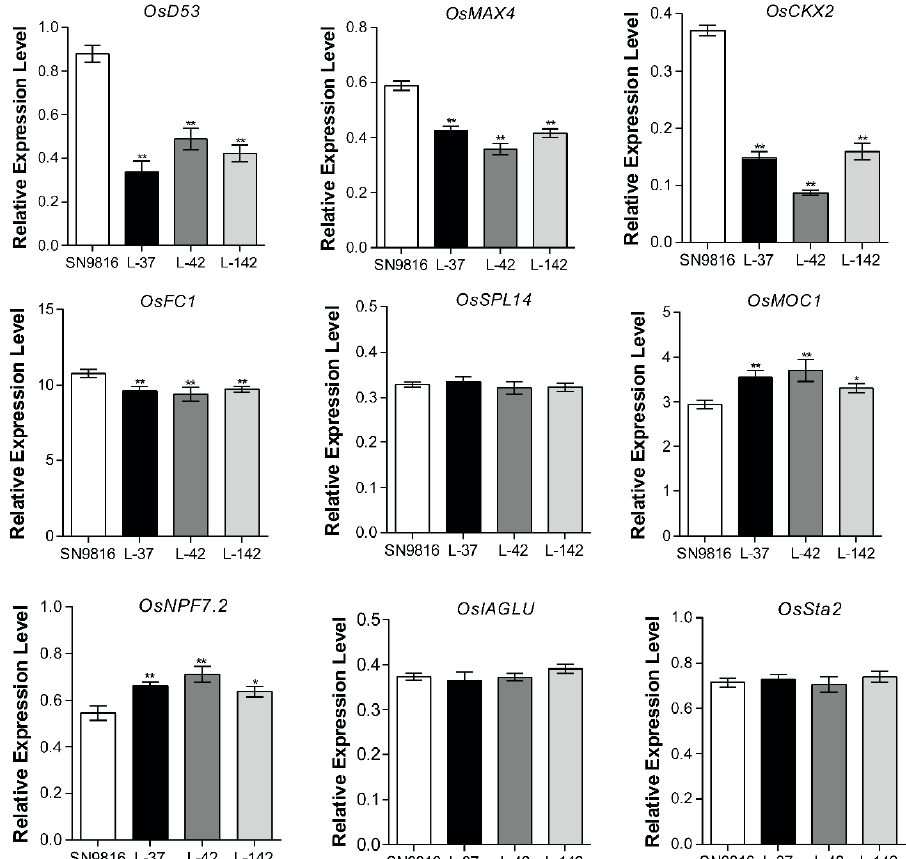
Figure 3. Overexpression of OsATG8c affected the expression of the tiller-related genes. The expression levels of strigolactone pathway genes ( OsD53 and OsMAX4 ), the cytokinin oxidase/dehydrogenase (CKX) enzyme coding gene OsCKX2 , tiller inhibiting genes ( OsFC1 and OsSPL14 ), and tiller promoting genes ( OsMOC1 , OsNPF7.2 , OsIAGLU and OsSta2 ) in the tiller buds of 32-day-old SN9816 and transgenic rice seedlings. Values are the means ± SD ( n = 10), * p < 0.05, ** p < 0.01 ( t -test).